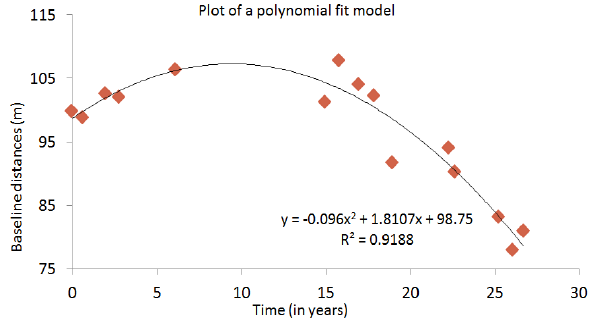
Figure 11. Polynomial regression fit between baseline distances and time for transect number 289 (numbering concerning the sector B) with Landsat midlines for 1984-2011.